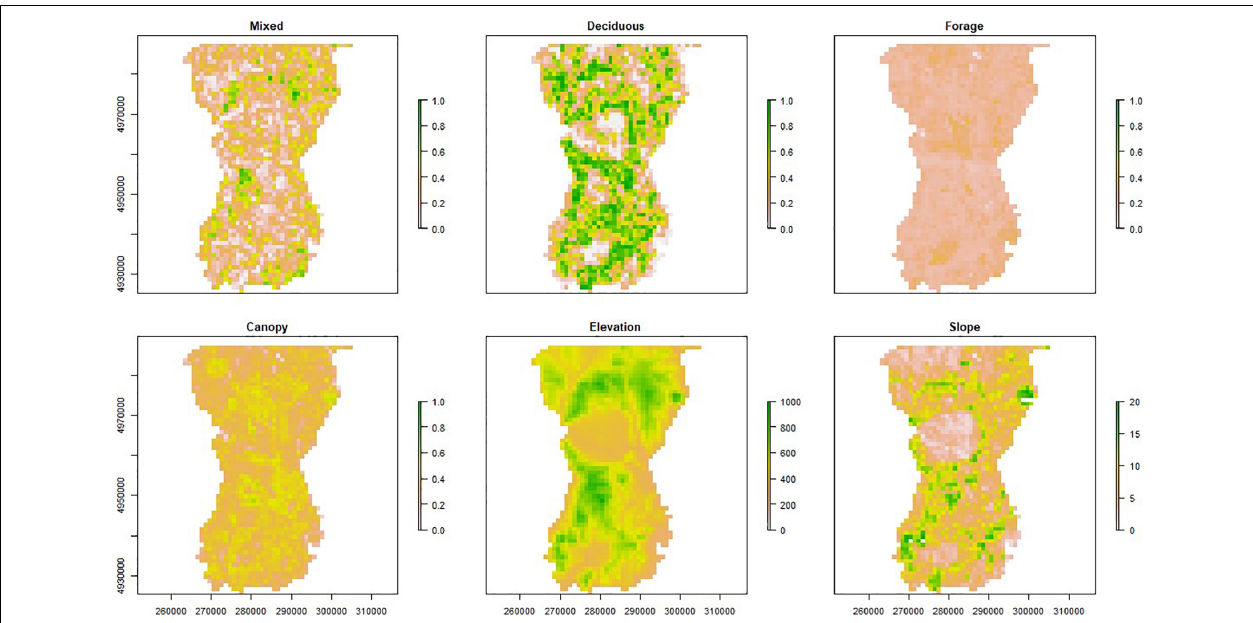
FIGURE 2 | Distribution of six important habitat variables for moose ( Alces alces ) in northeastern Vermont, United States. Measures include proportion for the structural components (e.g., canopy and forage; represented by lidar data) and composition variables (e.g., mixed and deciduous forest cover; represented by NLCD data), meters for elevation, and degrees for slope. Cell size is 1 km 2 and axes include UTM Easting and Northing